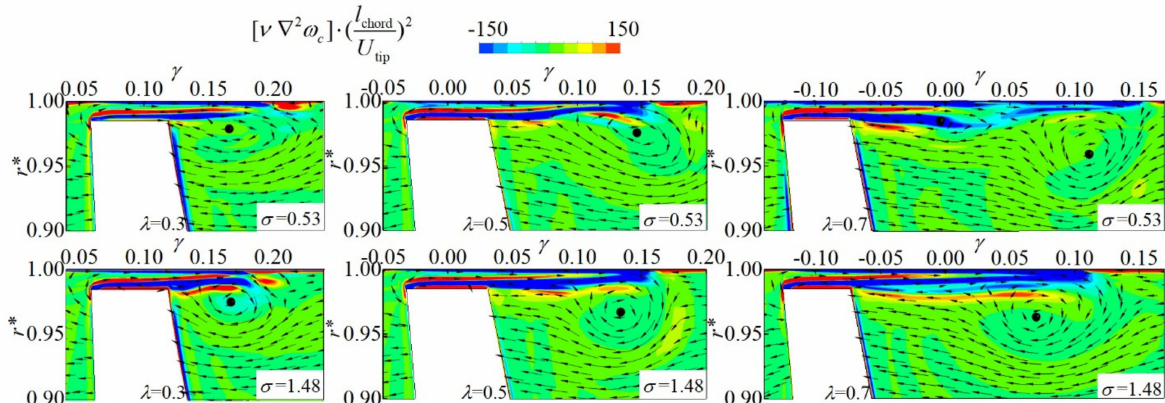
Figure 23. Comparison of viscous generation and dissipation term distributions on the three planes for the cavitating case ( upper ) and non-cavitating case ( lower